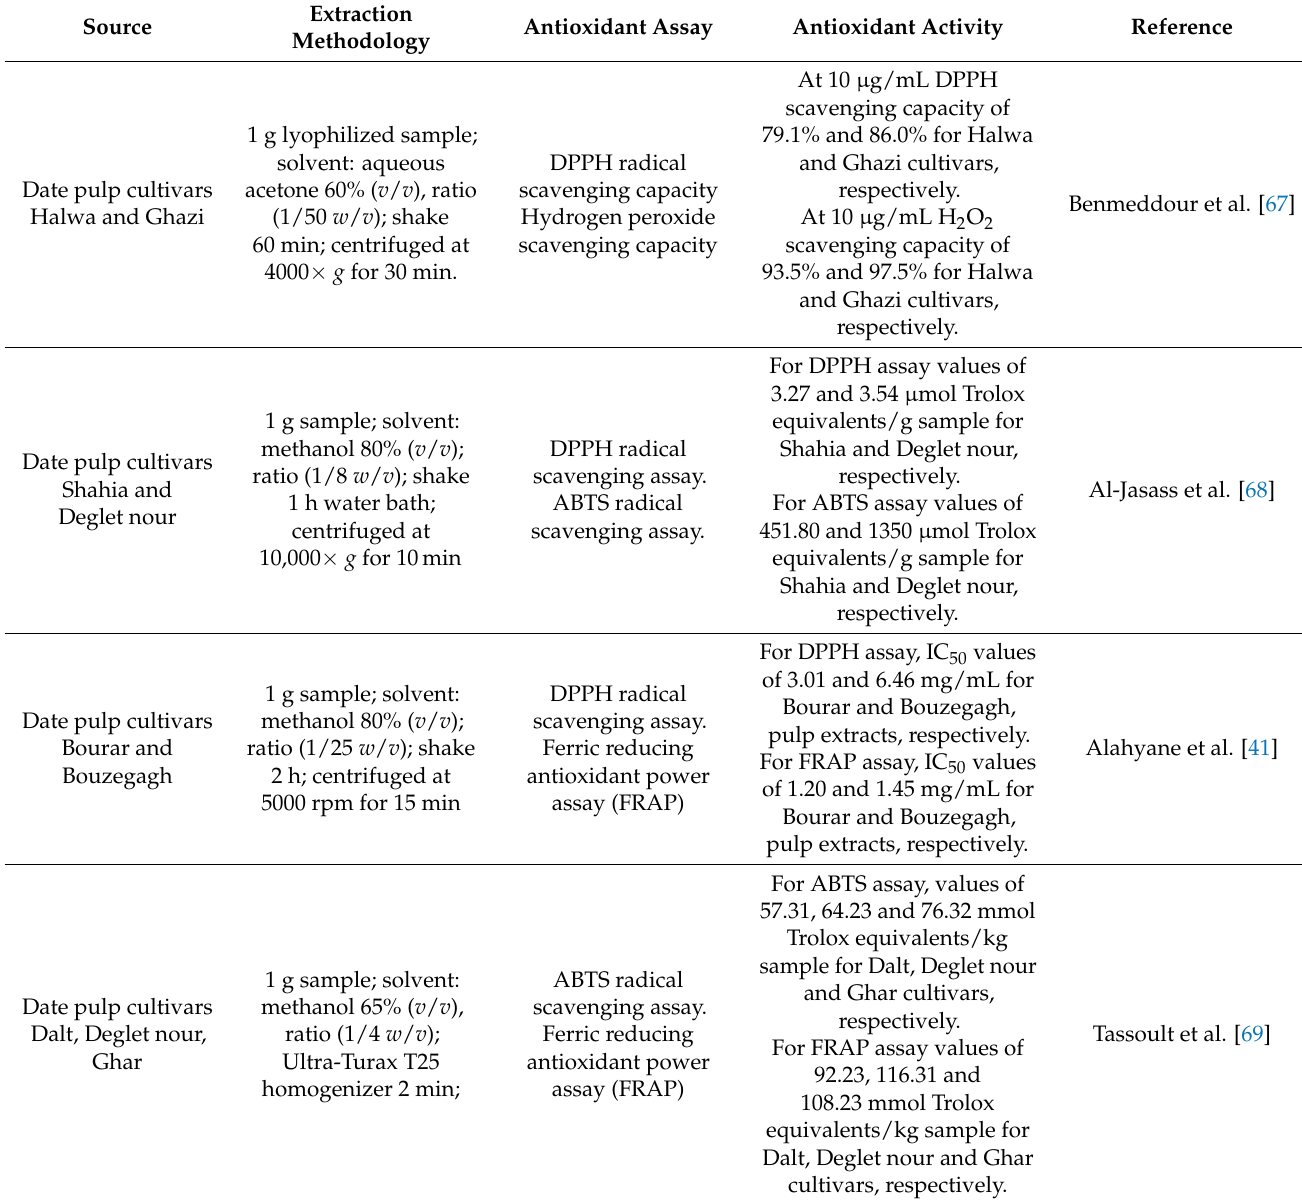
Table 3. Antioxidant activity of pulp and seeds extracts obtained from different date fruit